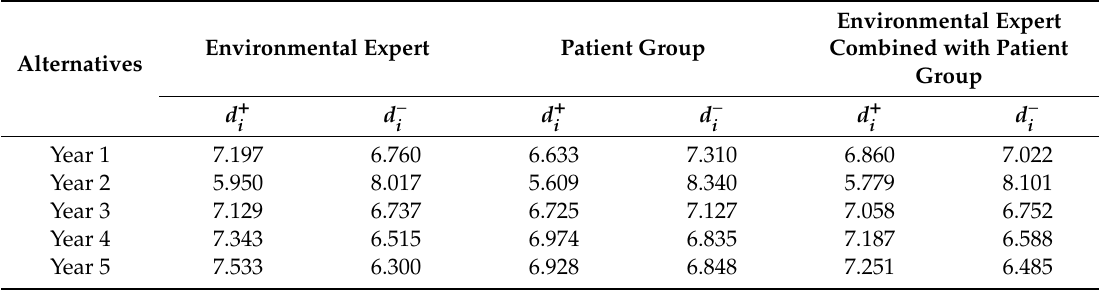
Table 8. Distances obtained from the expert, patient group judgements and combining the judgements of the expert and patient